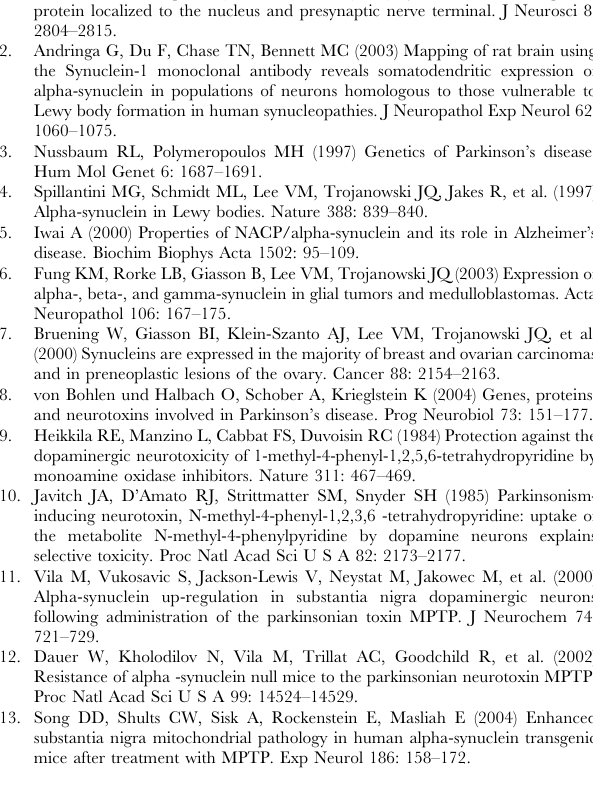
Figure S1 Transfection efficiency of human a -synuclein in SH-SY5Y cells. Different ratios of plasmid DNA ( m g)/